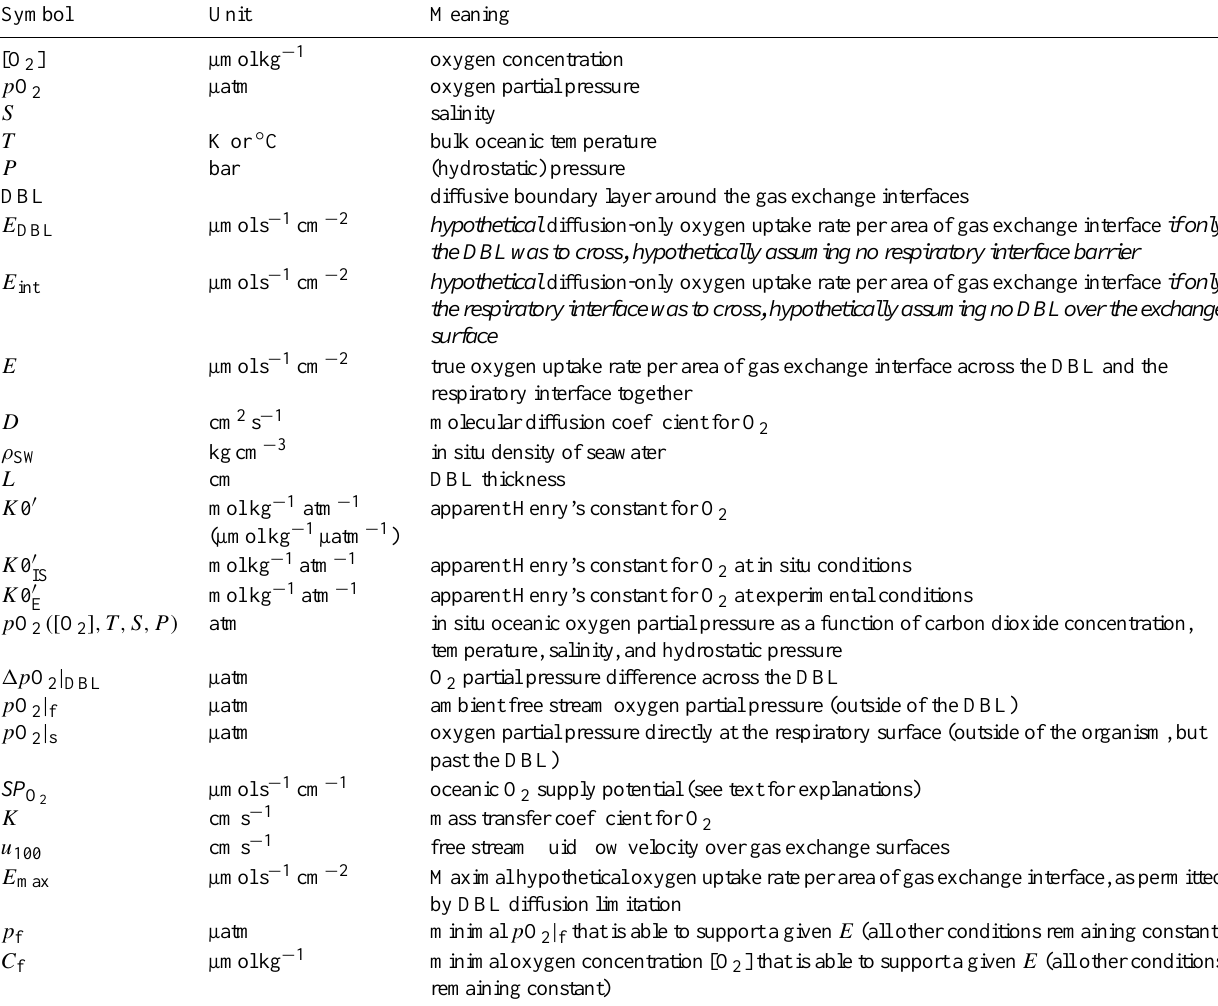
Table 1. List of symbols and abbreviations – listed in the order of their appearance in the manuscript. Symbol